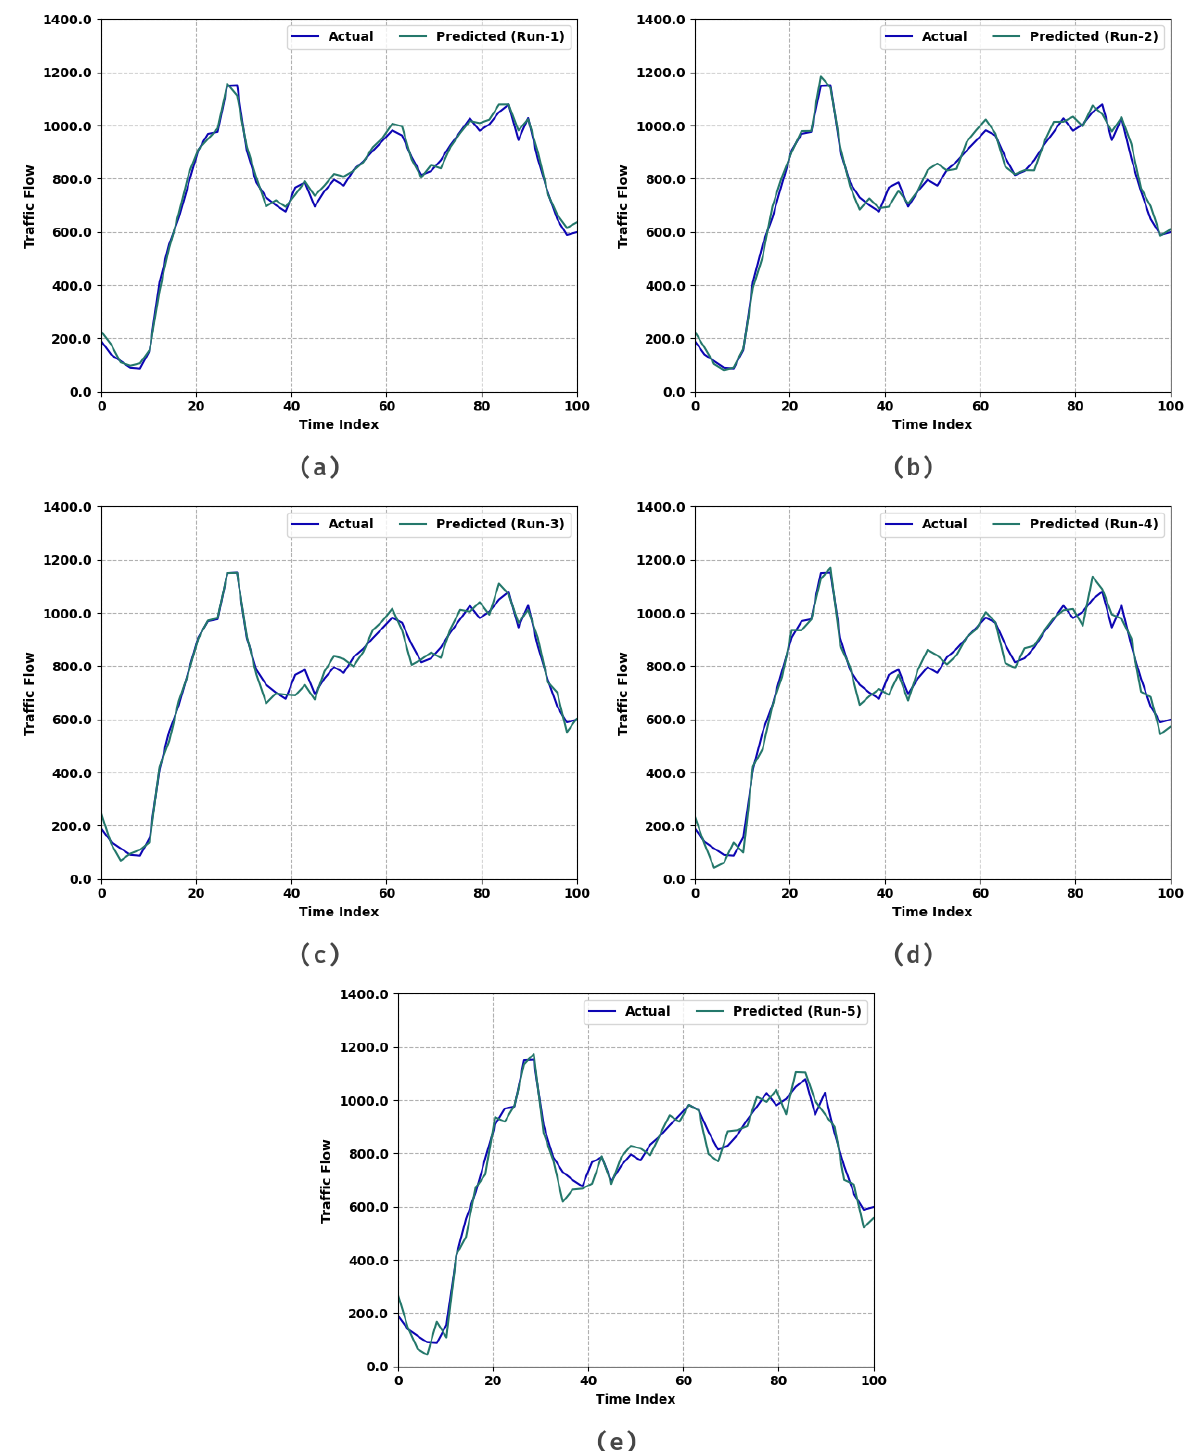
Figure 4. Traffic flow analysis of AST2FP – OHDBN approach ( a ) Run1, ( b ) Run2, ( c ) Run3, ( d ) Run4, and ( e ) Run5.